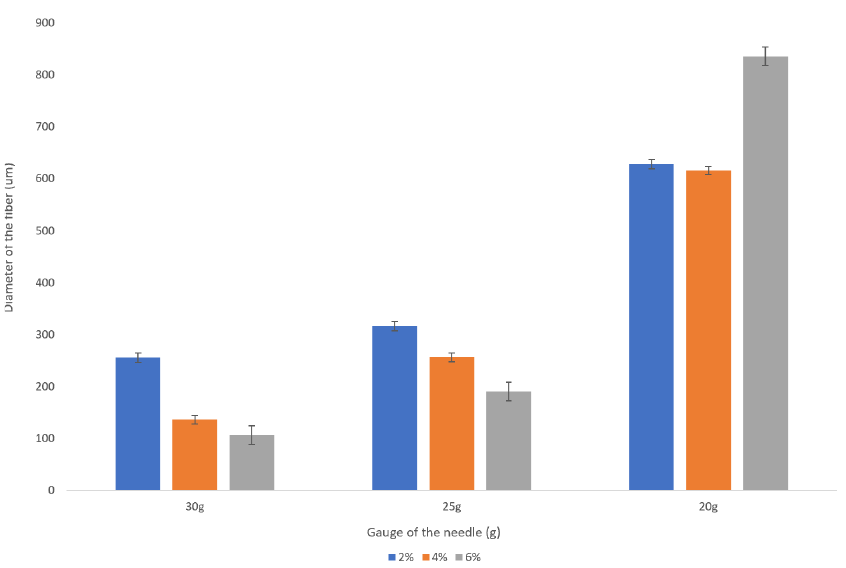
Figure 4. Dependence of the fiber diameter on the flow rate of the 2 wt % sodium alginate. There is no pronounced trend for the resulting fiber diameter with the increase in the flow rate from 1 mL/min to 2.7 mL/min. The error bars represent the standard deviation of the measurements.